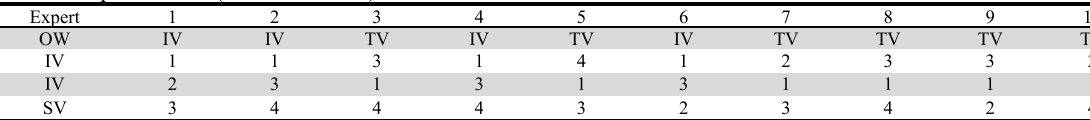
Main value preferences (Others to